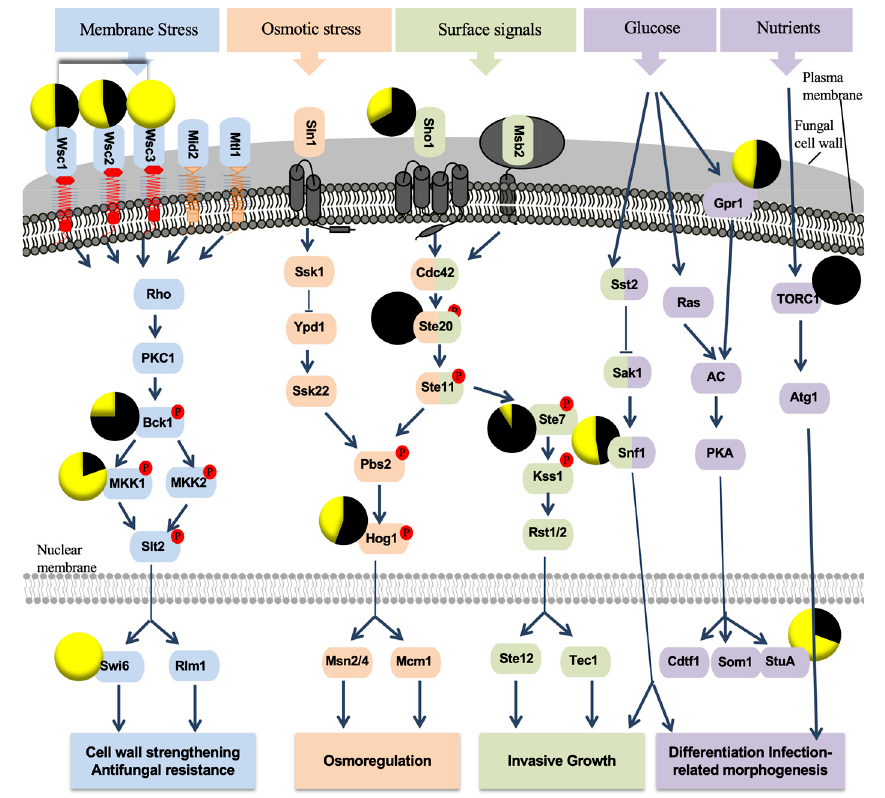
Figure 8. Protein kinase (PK) pathways in plant pathogenic fungi [22]. PKs are shown in colors. PKs involved in the same pathway have the same color. PKs involved in two different pathways are presented in two colors. Red circles containing the letter P indicate phosphorylated amino acid residues. Pie charts correspond to the expression level of Phaeomoniella chlamydospora genes encoding PKs in P. chlamydospora treatment (Black), and Pythium oligandrum + P. chlamydospora (yellow) treatments. Only PK genes detected in our data are shown. Expression level values are given as FPKM